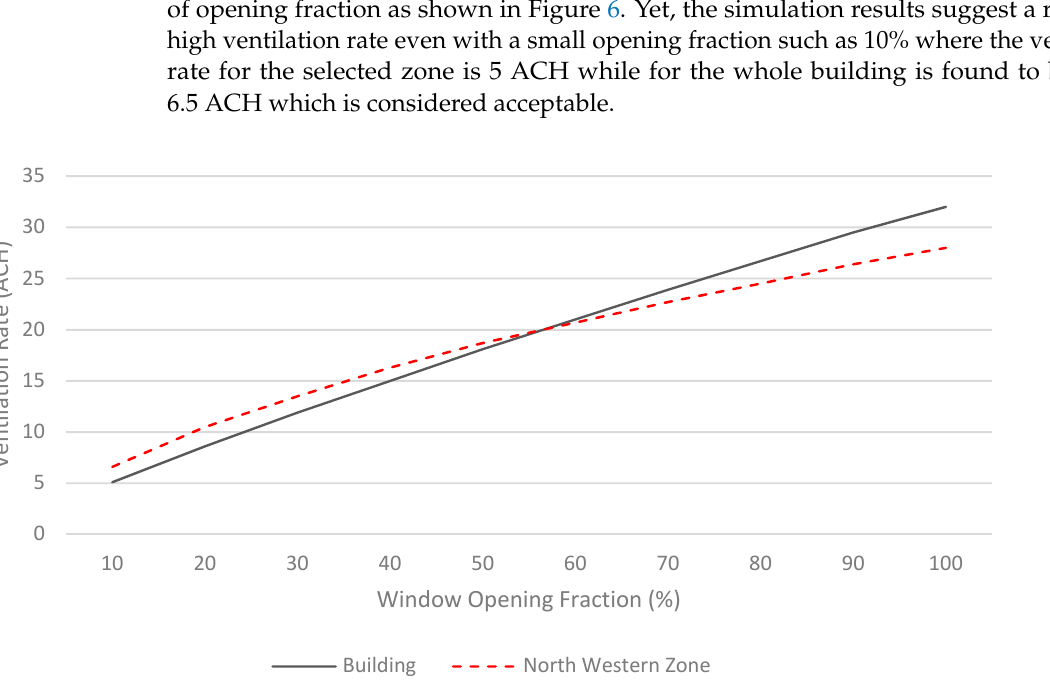
Figure 6. The effect of windows opening fraction on the ventilation rate of the building.